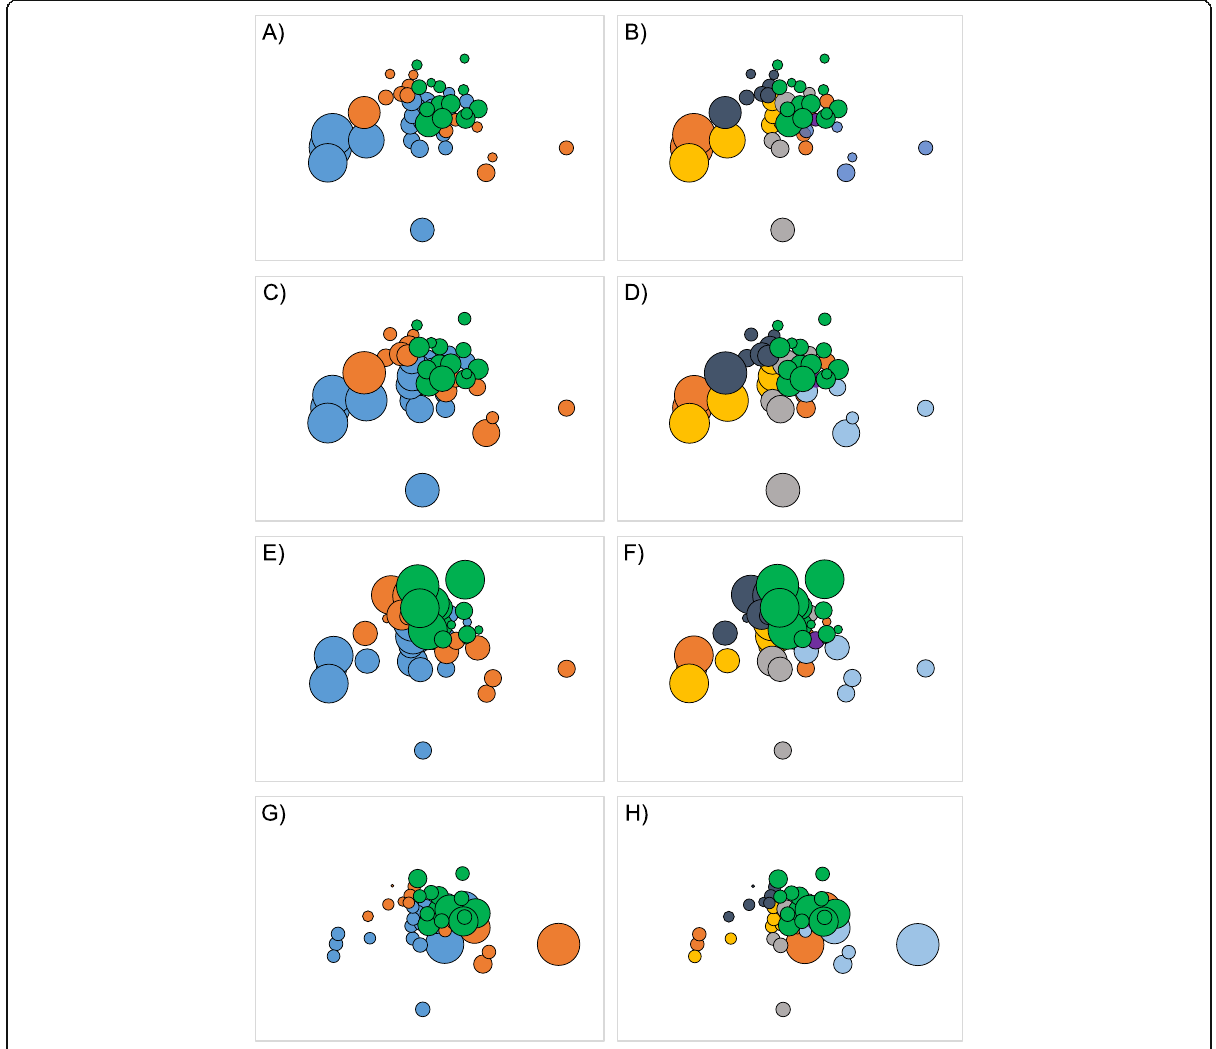
Fig. 7 n MDS of the set of environmental variables (surface and sea floor of the water column and sediments) that contributed most to the differentiation found by the DISTLM analysis. TOM % ( a , b ), Mean grain size ( c , d ), Sorting ( e , f ), pH superficial ( g , h ). ENV factor (left), MYT (light blue), SAL (orange) and REF (green); and CENTER factor (right); (Q1: orange, Q9: yellow, Q11: grey, Q2: light blue, Q6: purple, Q12: blue, REF: green). Stress: